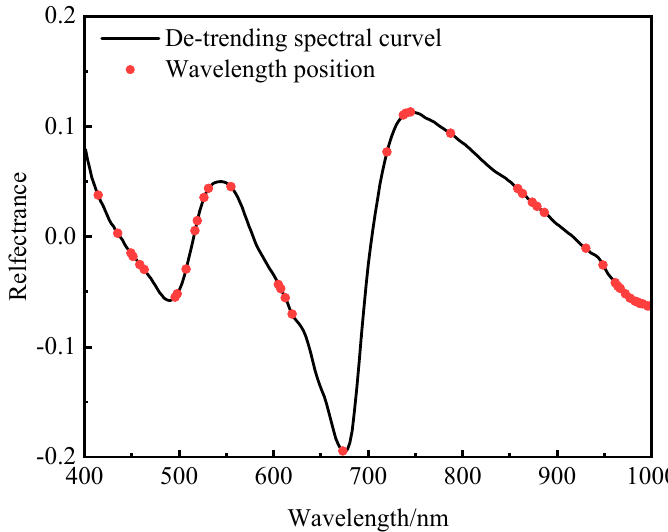
Figure 7. Characteristic wavelengths of the de-trending spectral curve selected using the CARS algorithm.